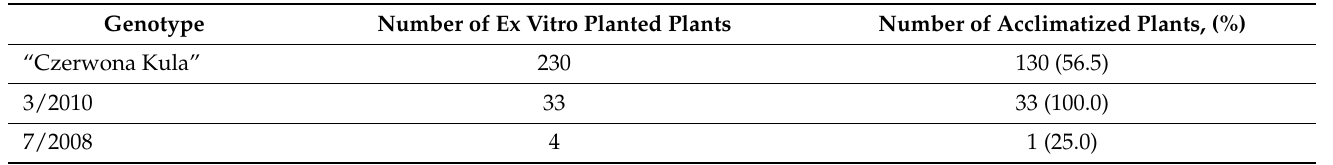
Table 8. Effect of the genotype on the efficiency of